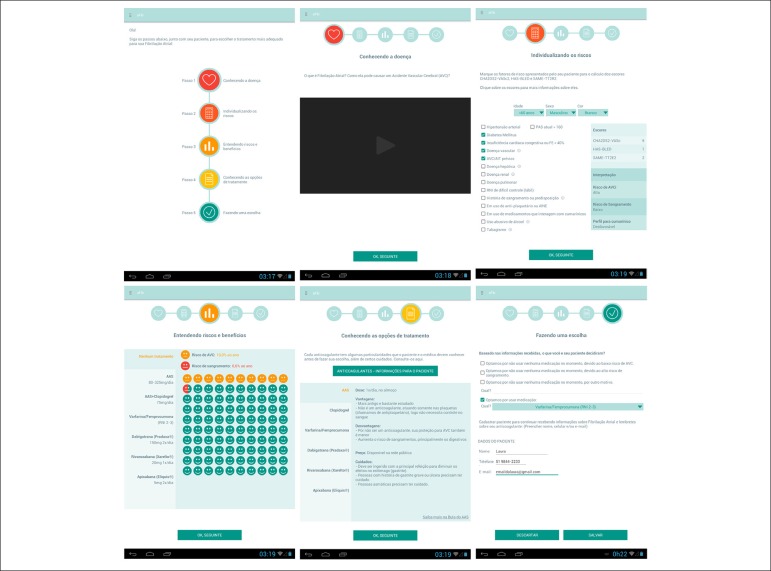
Main screens of the aFib app, developed to help in the shared
decision about thromboembolic prophylaxis in atrial
fibrillation.